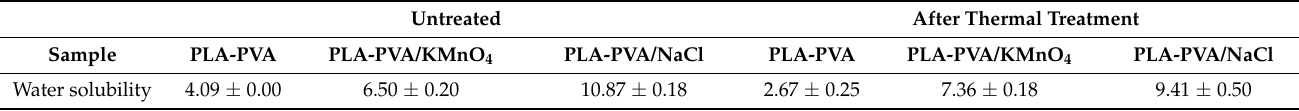
Table 3. Water solubility measurements of the porous bioscaffolds in DI water after 24 h at 37 ◦ C. Untreated After Thermal Treatment